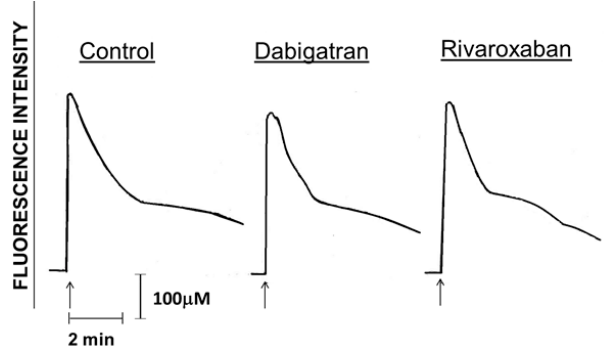
Figure 3. Traces from a typical experiment (3 in the series) using cells from different donors (3 in the series) showing the absence of effects of dabigatran and rivaroxaban (10 µM) on alterations in cytosolic Ca 2+ concentrations following activation of the cells with fMLP (1 µM) as indicated by the arrow ( ↑ ). Table 1. Effects of treatment of polymorphonuclear leukocytes (PMNL) with dabigatran and